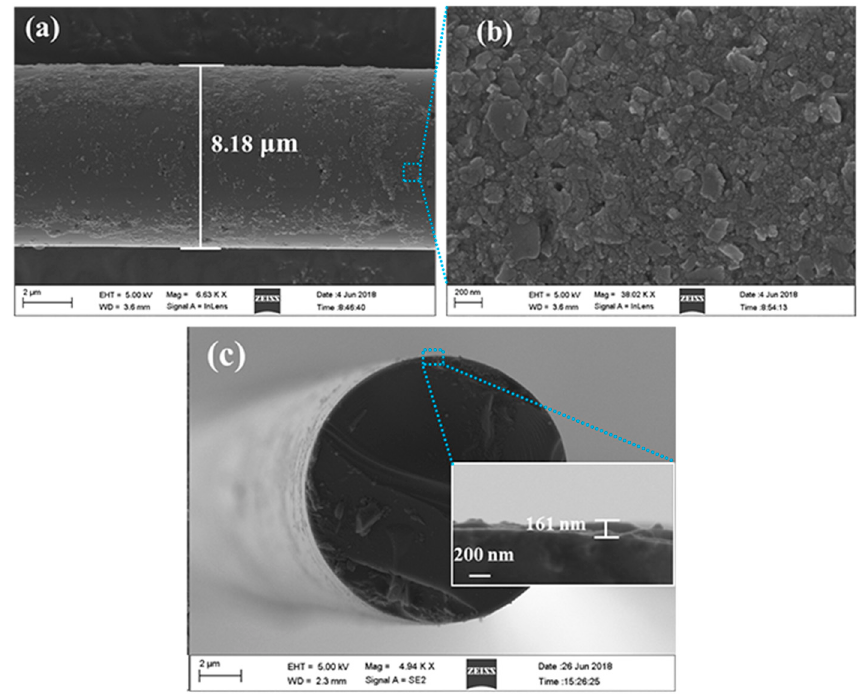
Figure 4. ( a ) SEM image of the MF coated with SnS 2 . ( b ) Enlarged image of the SnS 2 nanosheets on MF. ( c ) SEM image of the cross section of MF coated with SnS 2 . The inset enlarges the region marked by a dotted square.